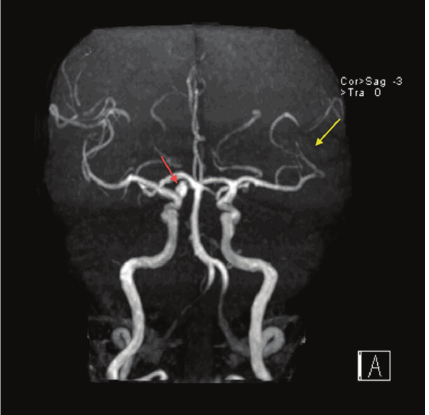
Figure 4: TOF-MRA scan in coronal view demonstrating cut-off at left upper division of MCA (yellow arrow). There is right ICA aneurysm (red